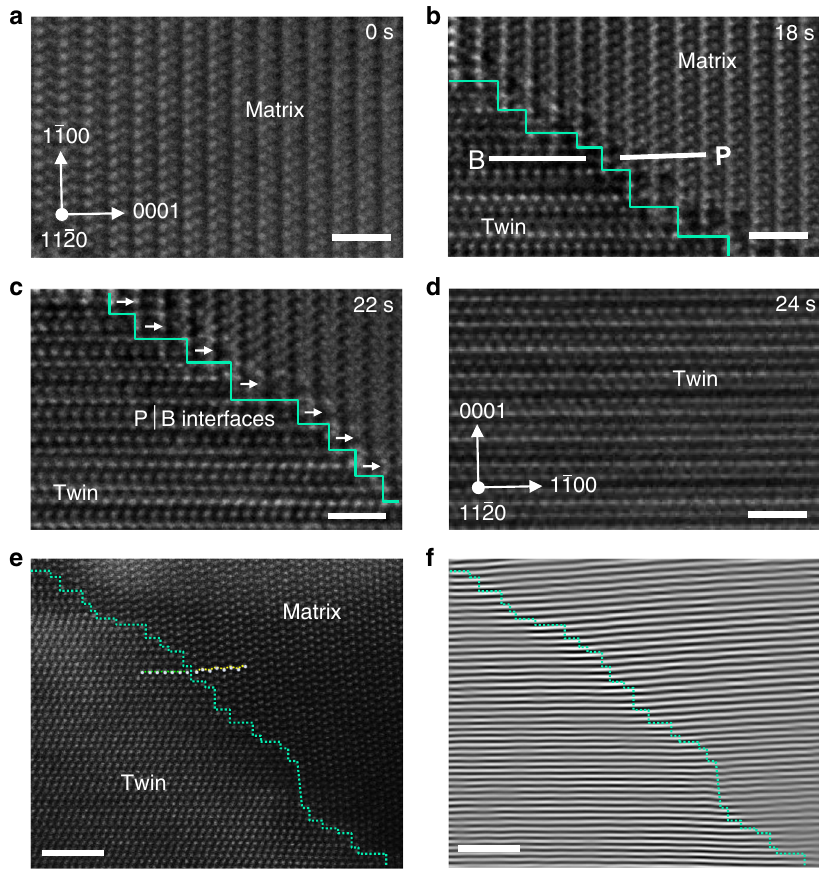
Fig. 2 Twin embryo growth mediated by disconnections on the P │ B interfaces. a – d Sequential HRTEM images showing the process. The zig-zag turquoise lines indicate the P │ B interfaces, wherein the step features are disconnections on the P │ B interface. Arrows indicate the moving direction of the disconnections. e Atomic-resolution HAADF-STEM image of the P │ B-type twin boundaries and f corresponding inverse fast Fourier transformation showing one-to-one correspondence between twin basal planes and matrix prismatic planes. Insets in e ) show the atomic models of the two types of plane. The zig-zag turquoise lines in e , f indicate the P │ B interfaces. Scale bars in a – d , 1 nm; scale bars in e – f , 2